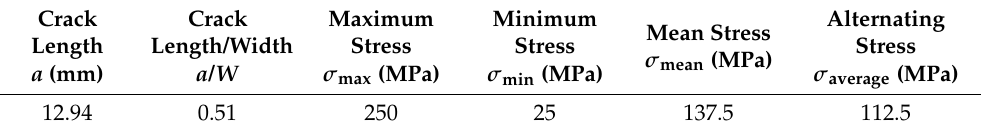
Table 2. Pre-cracking details of fracture toughness test.